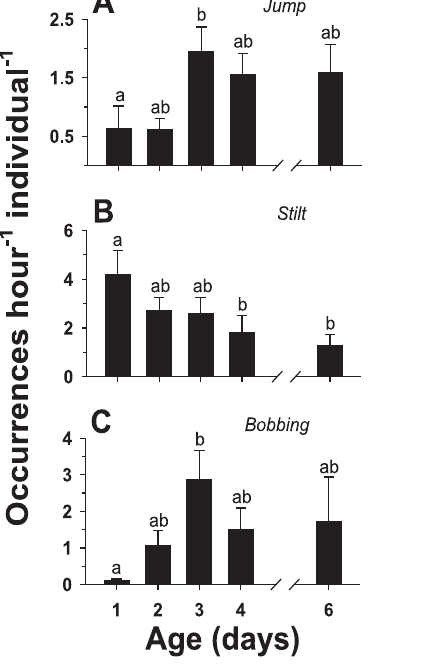
Figure 9. Ontogeny of infrequent non-interactive behaviors. Changes in the frequency of occurrence of three relatively infrequent non-interactive behaviors (see Table 1 for descriptions) in socially naı¨ve, male flesh flies with respect to adult age, in days: (A) jump , (B) stilt , and (C) bobbing . Flies were paired in a simple observation arena (the same experiment as Figs 5–8). Vertical bars indicate means 6 s.e.m. Different letters above the bars indicate significant differences.